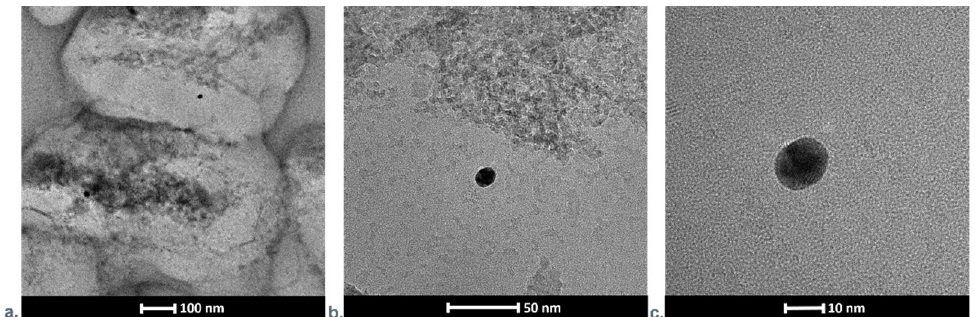
Figure 8. SEM images presenting HAP nanocrystal with adsorbed gold nanoparticles in different magnifications. ( a ) 100 nm, ( b ) 50 nm and ( c ) 10 nm.